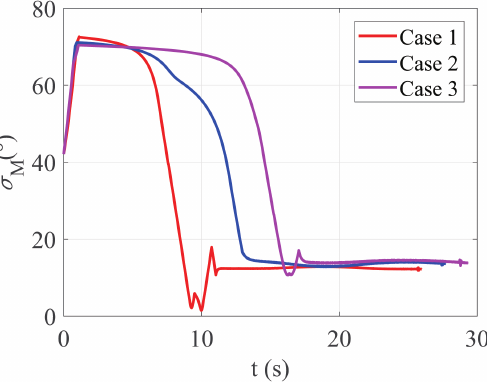
Figure 14. Variations of overall leading angles against variable maneuvering targets.